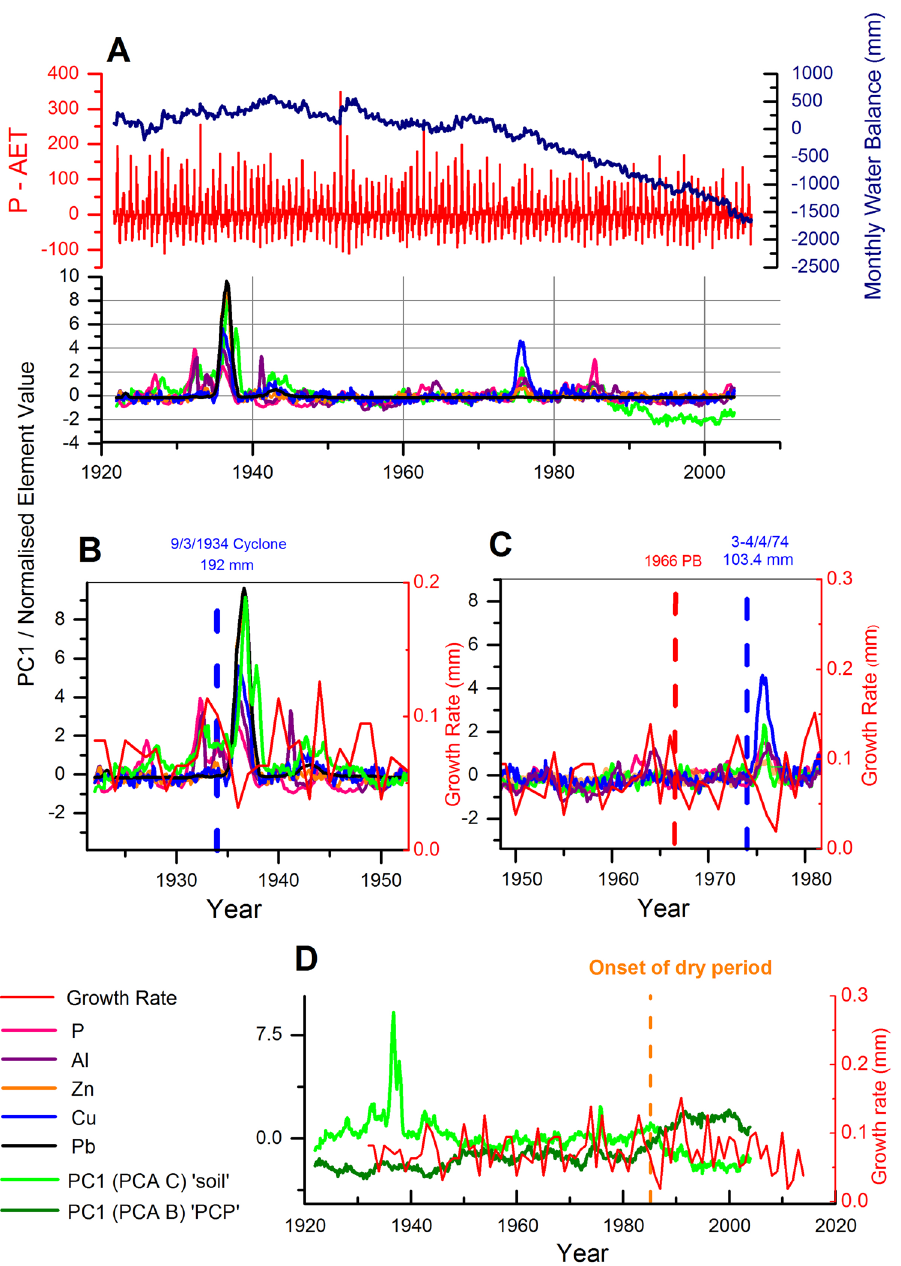
Figure 5. ( A ) A time series of water balance, normalised trace elements and PC1 (PCA C) ‘soil’ for stalagmite YD-S2; ( B,C ) Enlargements of PC1 ‘soil’, PC1 (PCA B) ‘PCP’, growth rate, and trace elements for 1934 cyclone and 1974 extreme rain events; and (D) PC1 ‘soil’, PC1 ‘PCP’ and growth rate with the period of post-1975 drying indicated. Trace element data are presented on separate panels in elementary Fig.